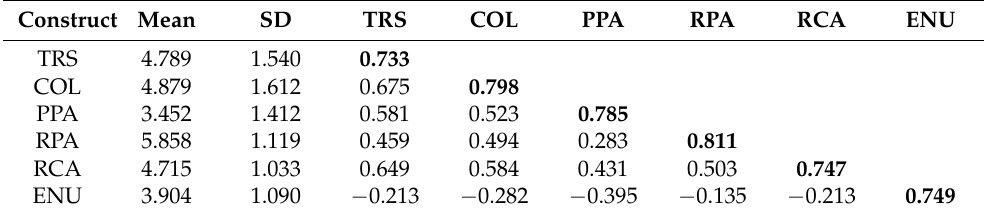
Table 5. Correlations and discriminate validity.